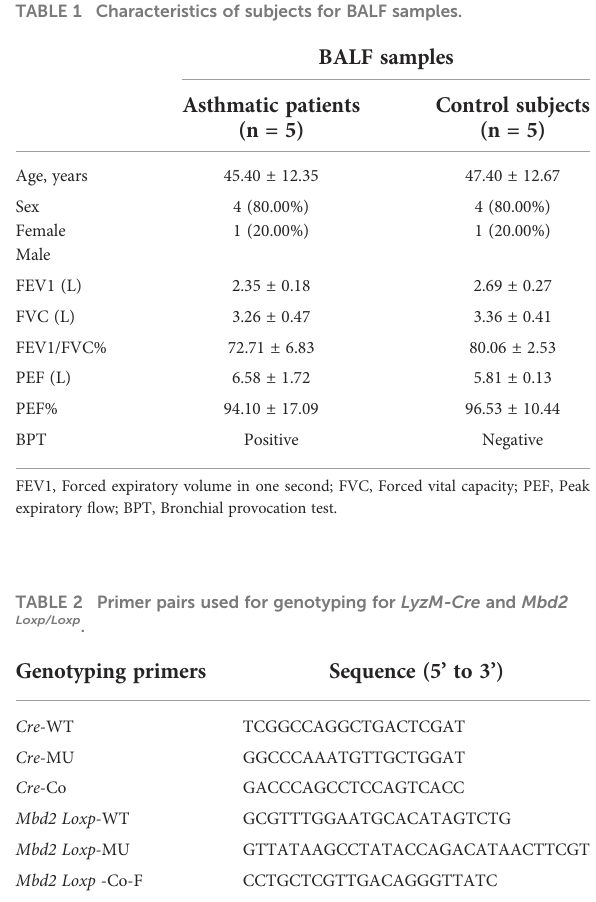
TABLE 1 Characteristics of subjects for BALF